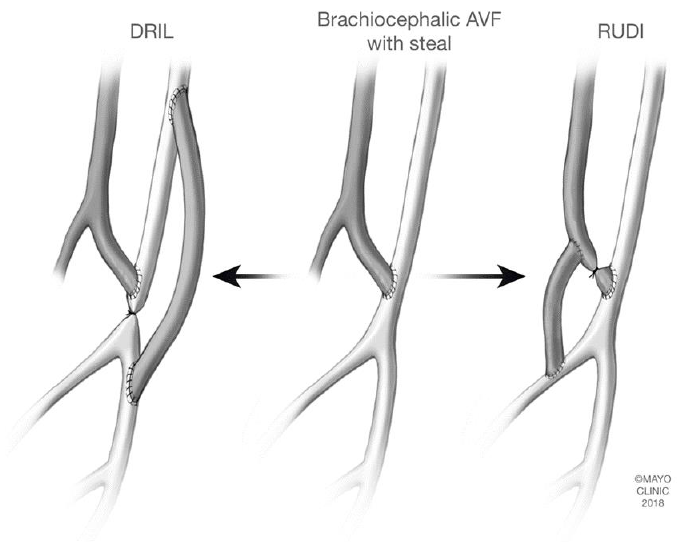
Figure 1. Revascularization for steal syndrome of a brachiocephalic arteriovenous fistula (AVF). Brachiocephalic AVF is shown in the center. The darker vessel represents the vein and the lighter vessel represents the artery. DRIL, distal revascularization-interval ligation, is shown on the left. The native artery is ligated distal to the AV anastomosis. Bypass is performed from the native artery proximal to the vascular access take off, to the native artery distal to the site of ligation. The bypass vessel is depicted in the dark color as a saphenous vein graft is commonly used. RUDI, revascularization using distal inflow, is depicted on the right. The original fistula is ligated and the AV anastomosis is relocated distally onto a smaller artery to limit flow to the AVF and also to increase flow through the ulnar artery. Copyright 2018 Mayo Foundation for Medical Education and Research.